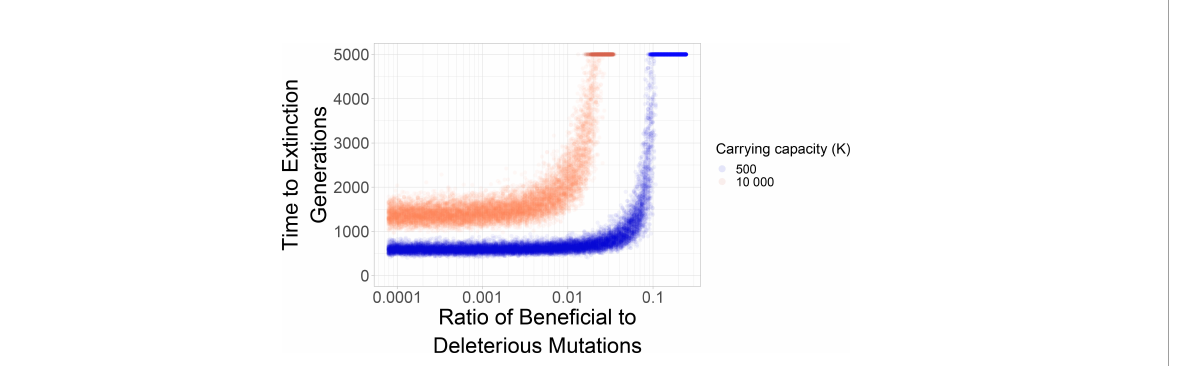
FIGURE 2 Mutational meltdown can be prevented with suf fi cient continual input of bene fi cial mutations. The sharp survival threshold depends strongly on the carrying capacity. The population can escape mutational meltdown when the ratio of bene fi cial to deleterious mutations is ≈ 10%, when the carrying capacity is K=500; a ratio of ≈ 1% is suf fi cient for escape from mutational meltdown when K=10000. Each dot represents a simulation